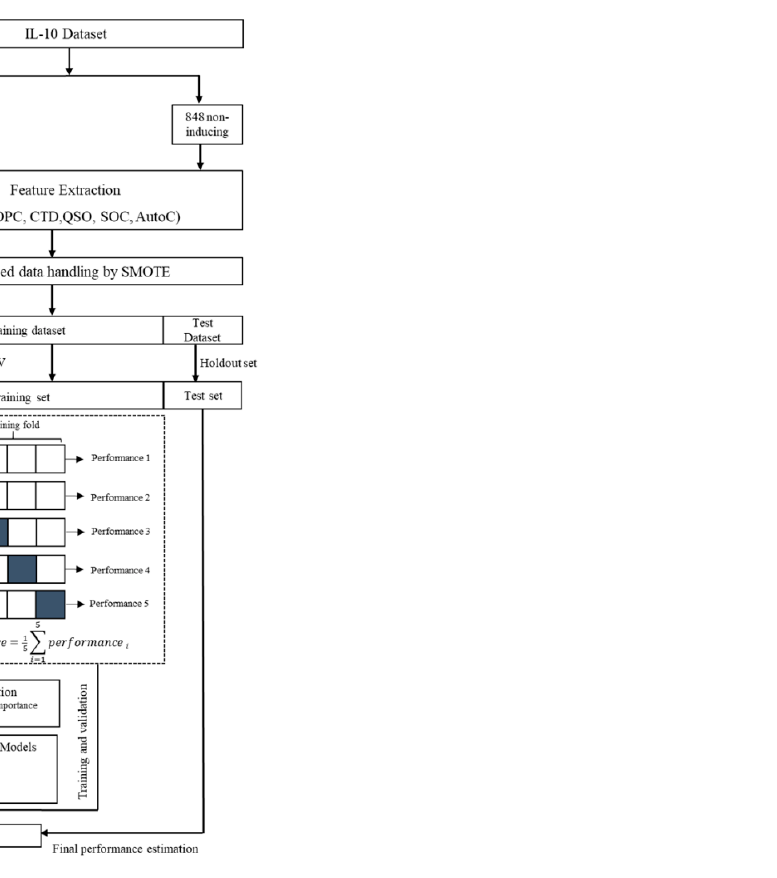
Figure 1. The systematic architecture of the proposed method, Ileukin10Pred, which included dataset collection, feature generation, SMOTE, feature selection, machine learning algorithms, and an evaluation process.